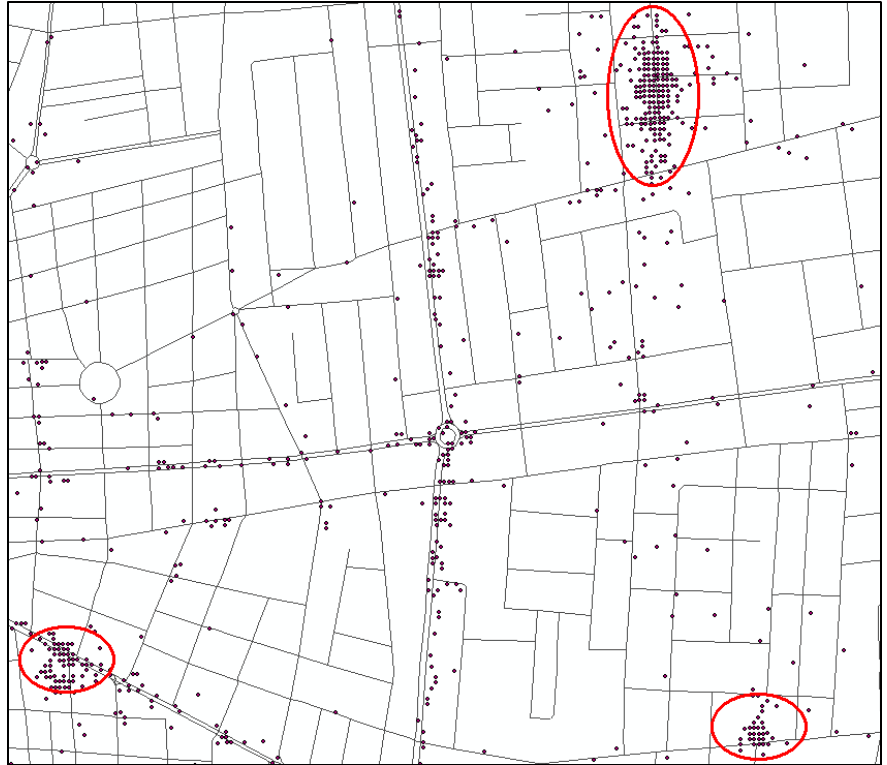
Table 2. Summary of the number of the reported traffic accidents in the Irbid Governorate during 2015–2019.